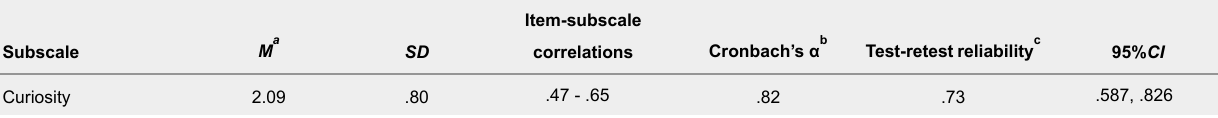
Subscale Statistics of the Chinese Translated Toronto Mindfulness Scale – Trait Version (C-TMS-T) and Test-Retest